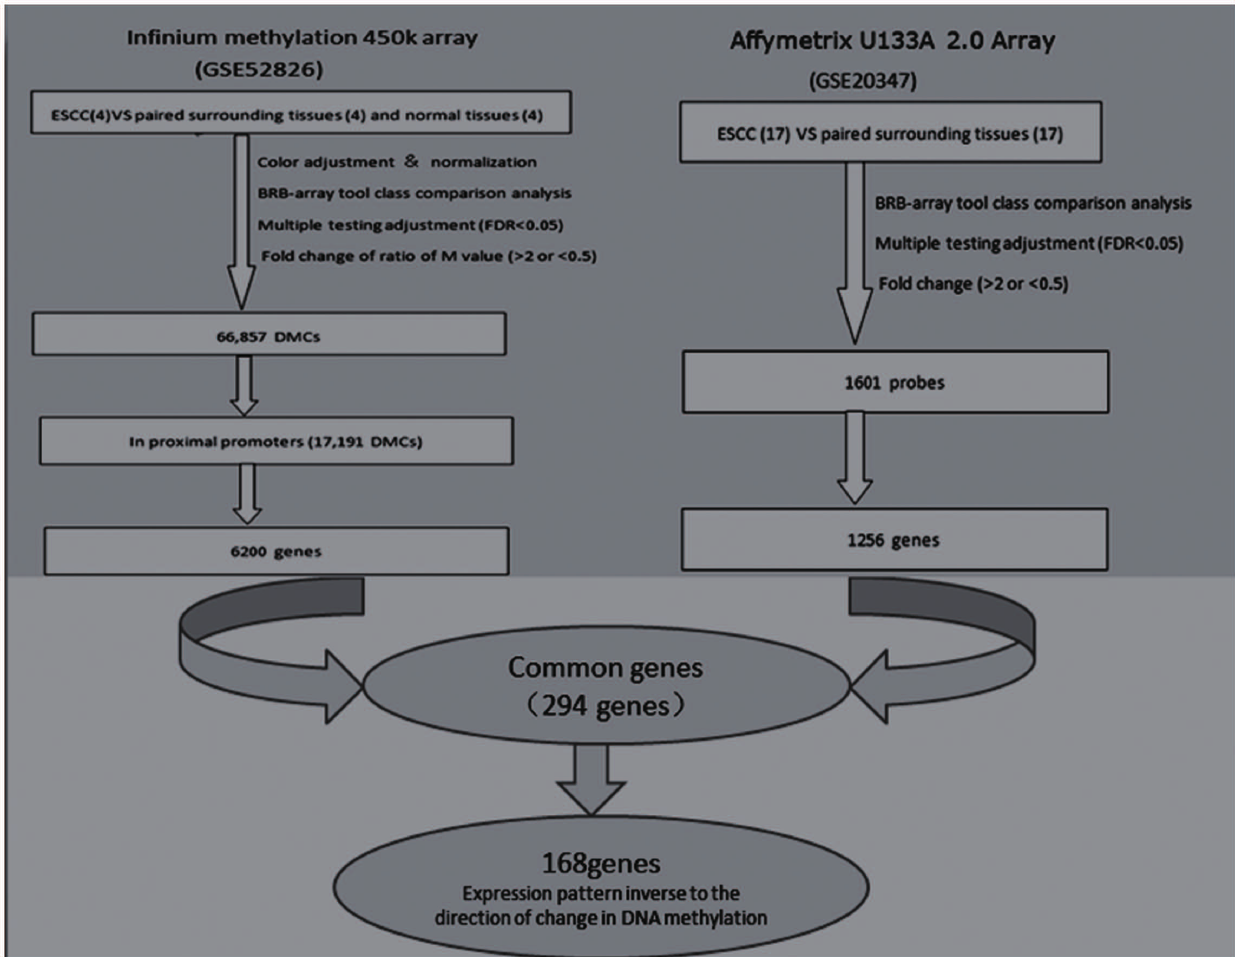
Figure 3. Combination analysis between DNA methylation data and gene expression data identified 168 differentially methylated genes in ESCC. Methylation data analysis showed 66,857 DMCs, which related to 6,200 genes (gene set 1). Expression data analysis showed 1,601 probe differences between ESCC and control, which related to 1.256 genes (gene set 2). There were 294 common genes between gene set 1 and gene set 2. 168 genes were selected due to inverse correlation between DNA methylation and expression change.